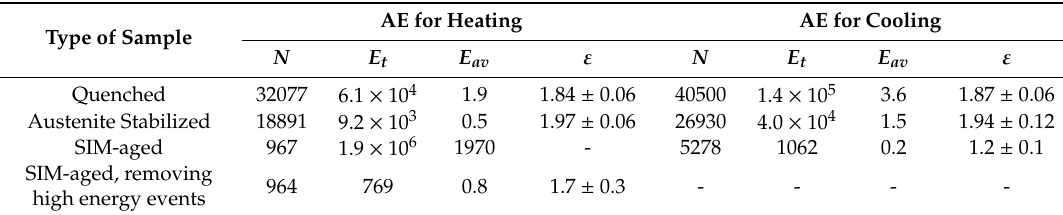
Table 3. Critical energy exponents, ε , and energies of hits in the acoustic noises for heating and cooling at 10 K / min for the quenched, austenite stabilized and SIM-aged Ni 51 Fe 18 Ga 27 Co 4 single crystals. E t is (cid:80) ) , E av is the average peak energy ( E av = the sum of peak energies ( i E i hits). The energies are given in µ · V 2 · Ω − 1 s